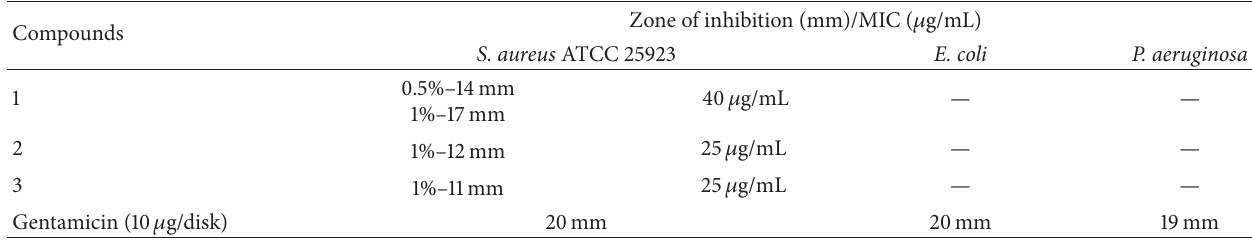
Table 1: Antimicrobial activity of